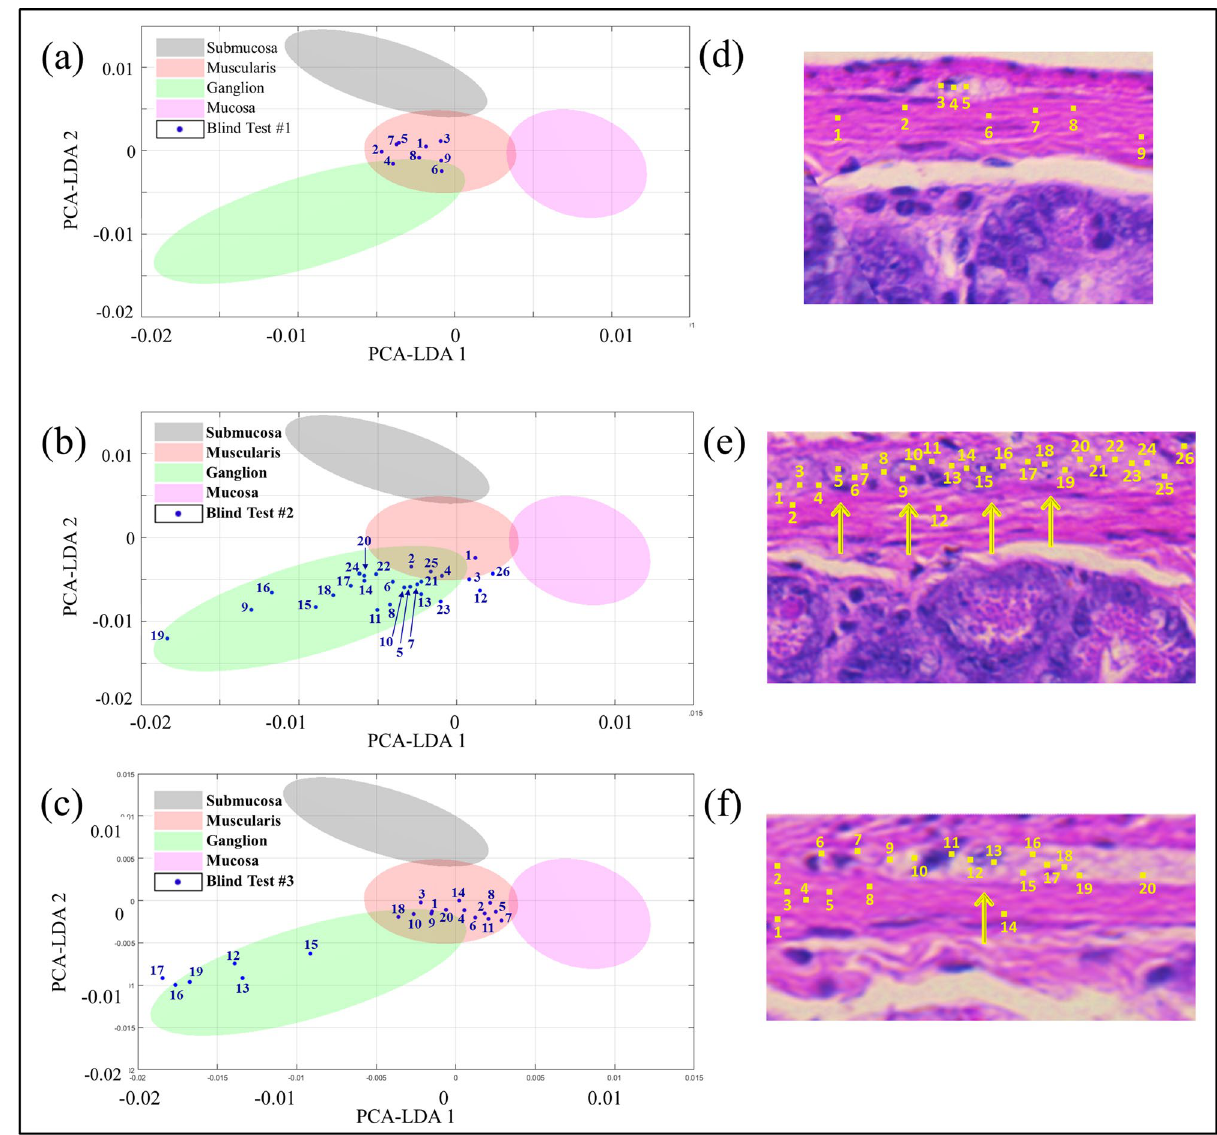
Figure 9. ( a – c ) 2-D PCA plot showing the classification of the Raman spectra acquired from different locations in the tissue specimens (blue dots) based on the PCA-LDA model (shadowed ellipses) defined by the previous Raman spectral data from Fig. 7. ( d – f ) H&E images showing the location of ganglion cells (yellow arrows) and the numbered locations where Raman spectra were